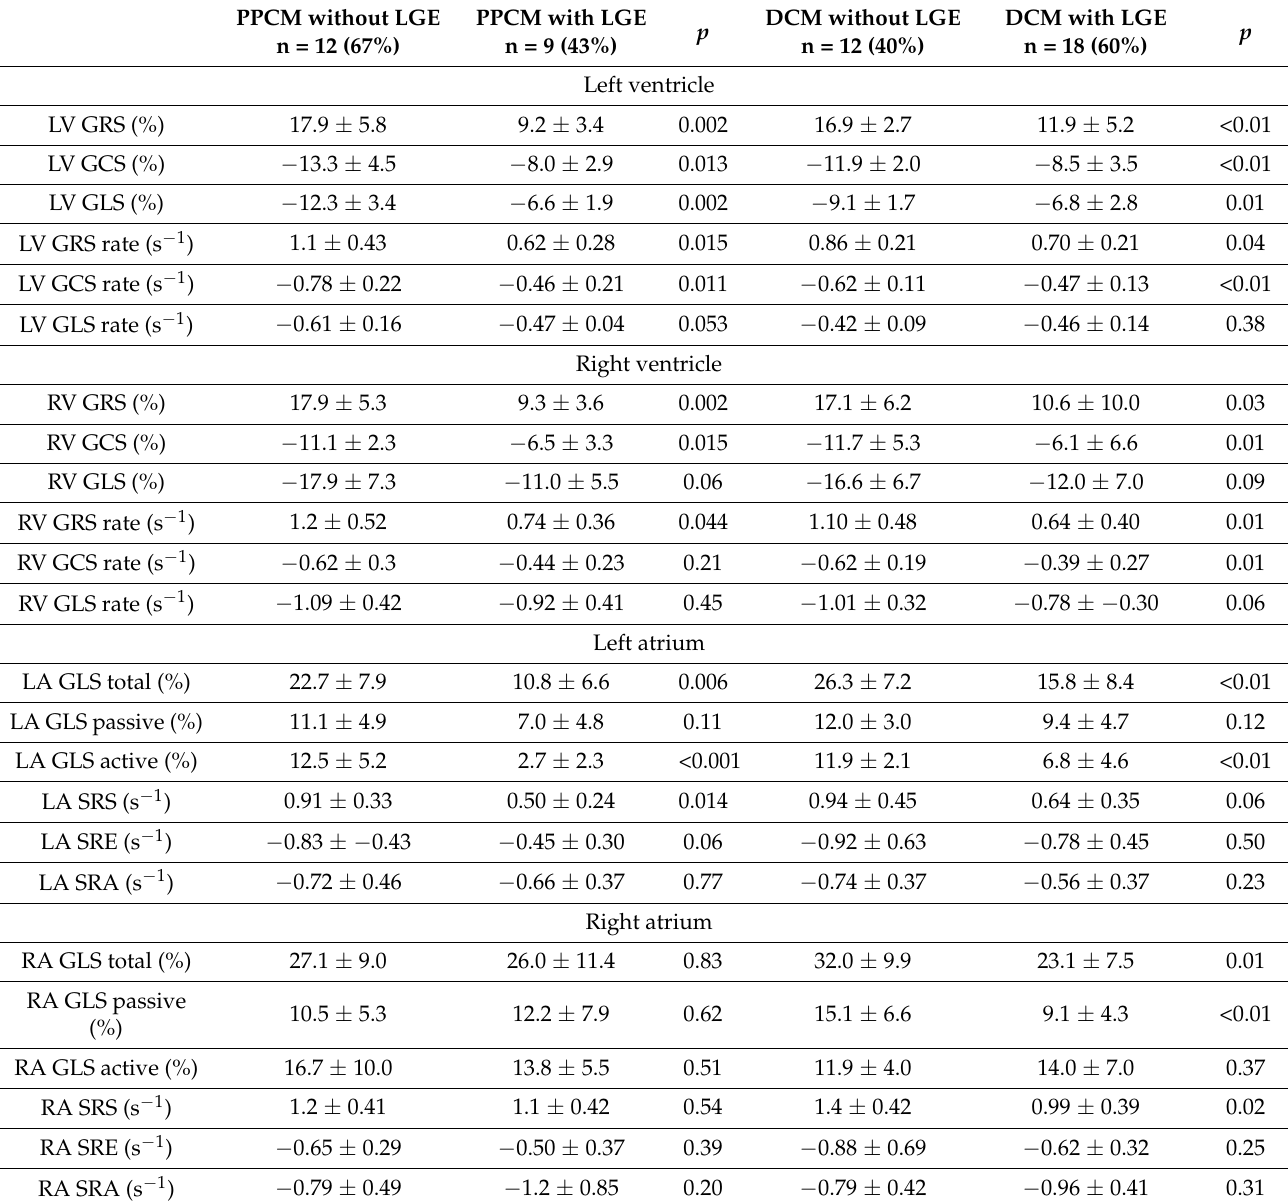
Table 4. CMR-FT derived strain parameters in patients with PPCM with and without LGE. PPCM without